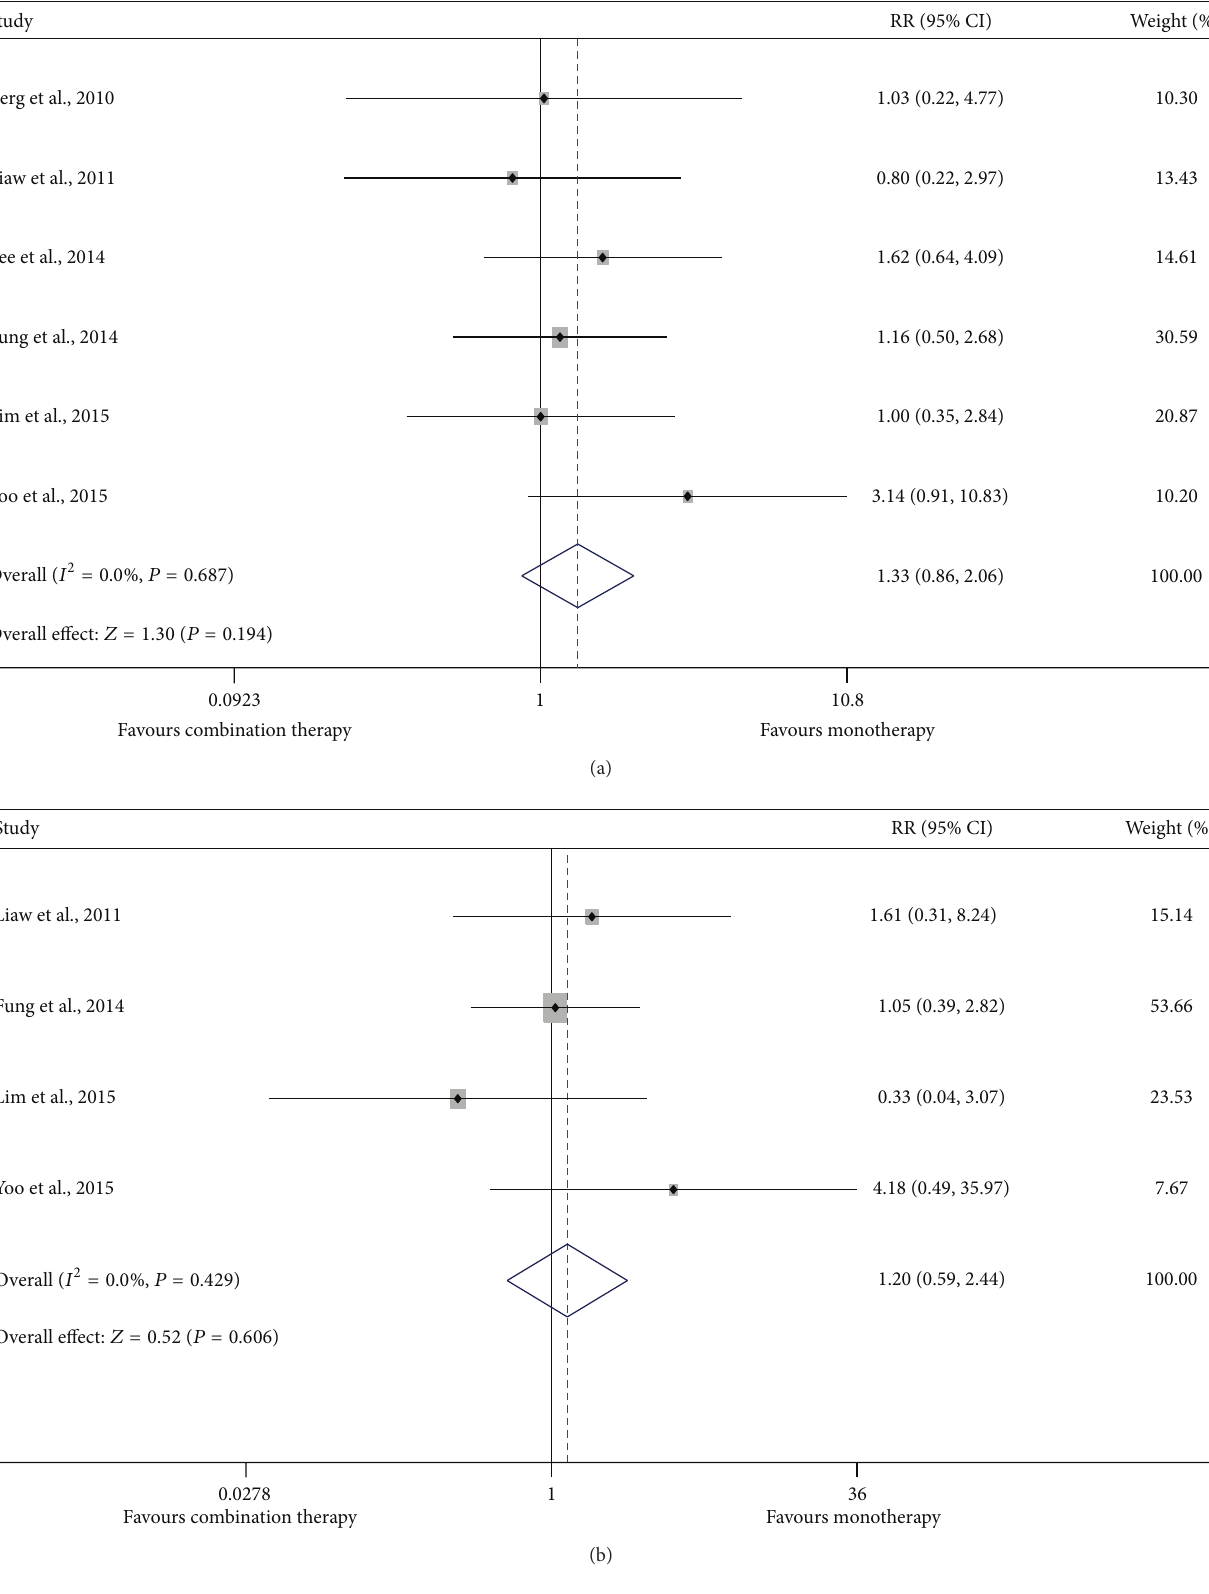
Figure 3: Forest map of summary estimates for comparison of the changes in HBeAg between TDF-based combination therapy and monotherapy groups. (a) HBeAg loss; (b) HBeAg